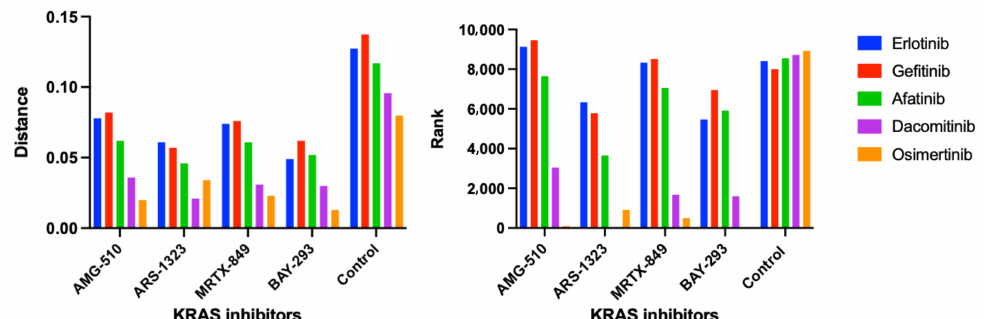
Figure 3. KRAS and EGFR inhibitor similarity scores and rankings using the CANDO platform. Following the generation of the compound-proteome interaction signatures for all drugs/compounds in our library, the similarity scores and rankings were calculated between four KRAS inhibitors AMG-510/sotorasib, ARS-1323 (racemate of ARS-1620), MRTX-849/adagrasib, BAY-293, and all other compound signatures. Overall, we found high similarity between our four KRAS inhibitors and EGFR inhibitors erltotinib, gefitinib, afatinib, dacomitinib, and osimertinib using the cosine distance between the interaction signature vectors (Section 3.5). The left panel shows the average similarity scores (vertical axis) for the five first, second, and third generation EGFR inhibitor interaction signatures (colored bars) compared to the signatures of four KRAS inhibitors (horizontal axis). The average similarity scores for each EGFR inhibitor signature compared to those from our entire 13,217 drug/compound library are also shown as a control. The corresponding pairwise signature similarity rankings (vertical axis) are displayed on the right panel. Overall, KRAS G12 inhibitors were predicted to be highly similar to EGFR inhibitors relative to the average drug/compound in our library. Osimertinib, a third generation EGFR inhibitor, was calculated to be the most similar to all the four KRAS inhibitors relative to the other EGFR inhibitors, and was ranked first when compared to BAY-293 relative to the entire compound library. Created with